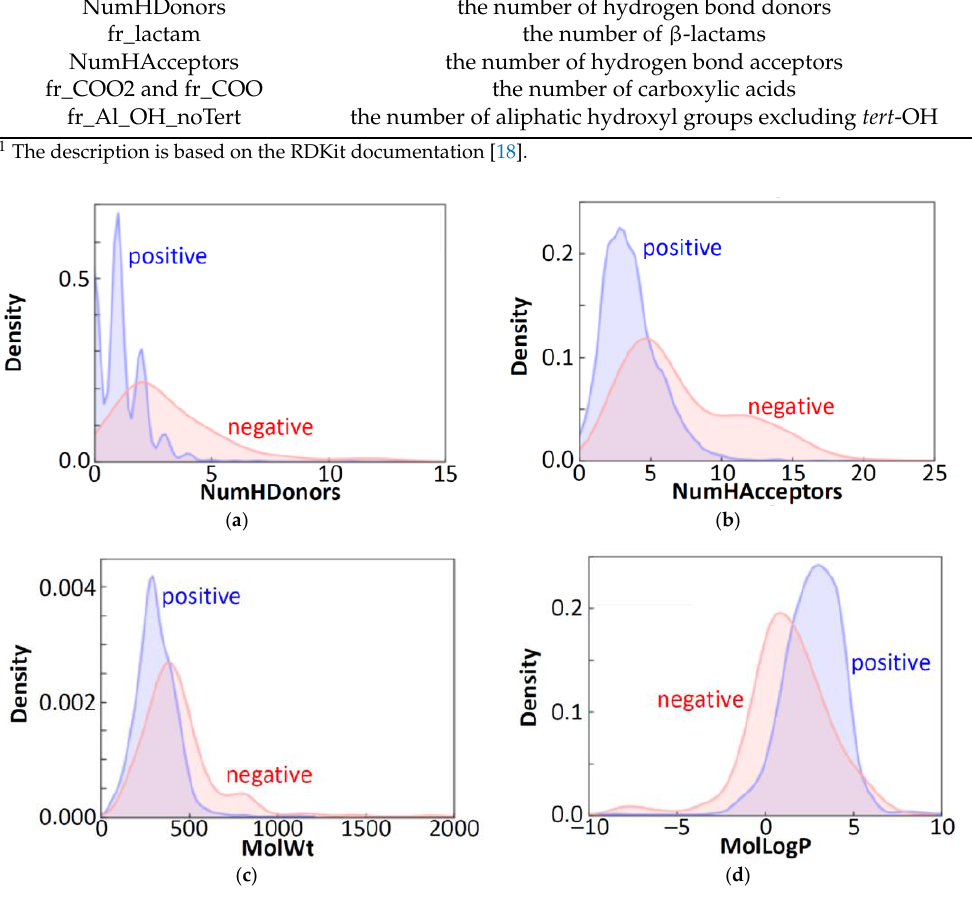
Figure 4. Distribution of positive and negative BBBP properties in the free-form dataset with respect to the number of hydrogen bond donors ( a ), the number of hydrogen bond acceptors ( b ), the molecular weight ( c ), and the MolLogP value ( d ).